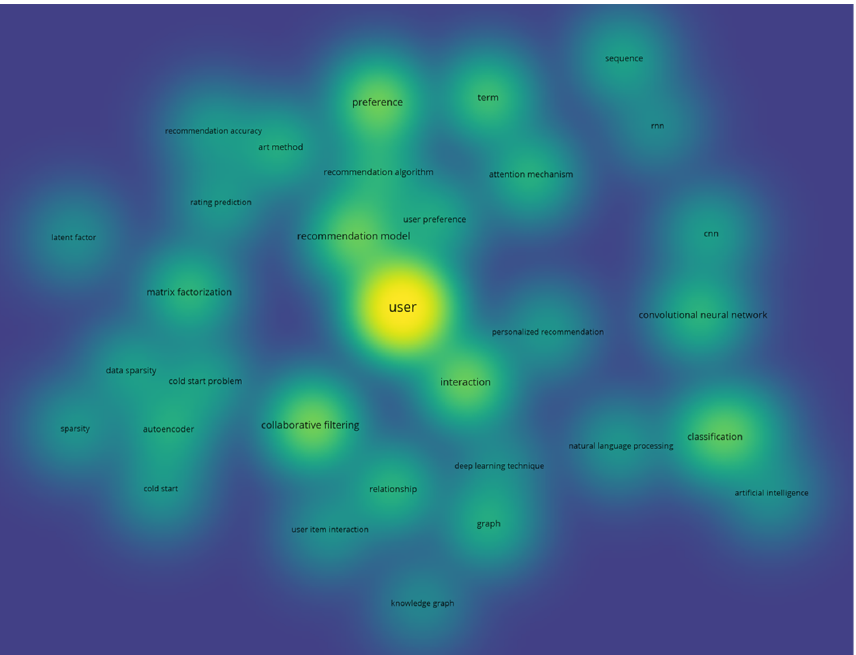
Figure 4. Network visualization for the POI recommendation with deep-learning keywords with VOSviewer.